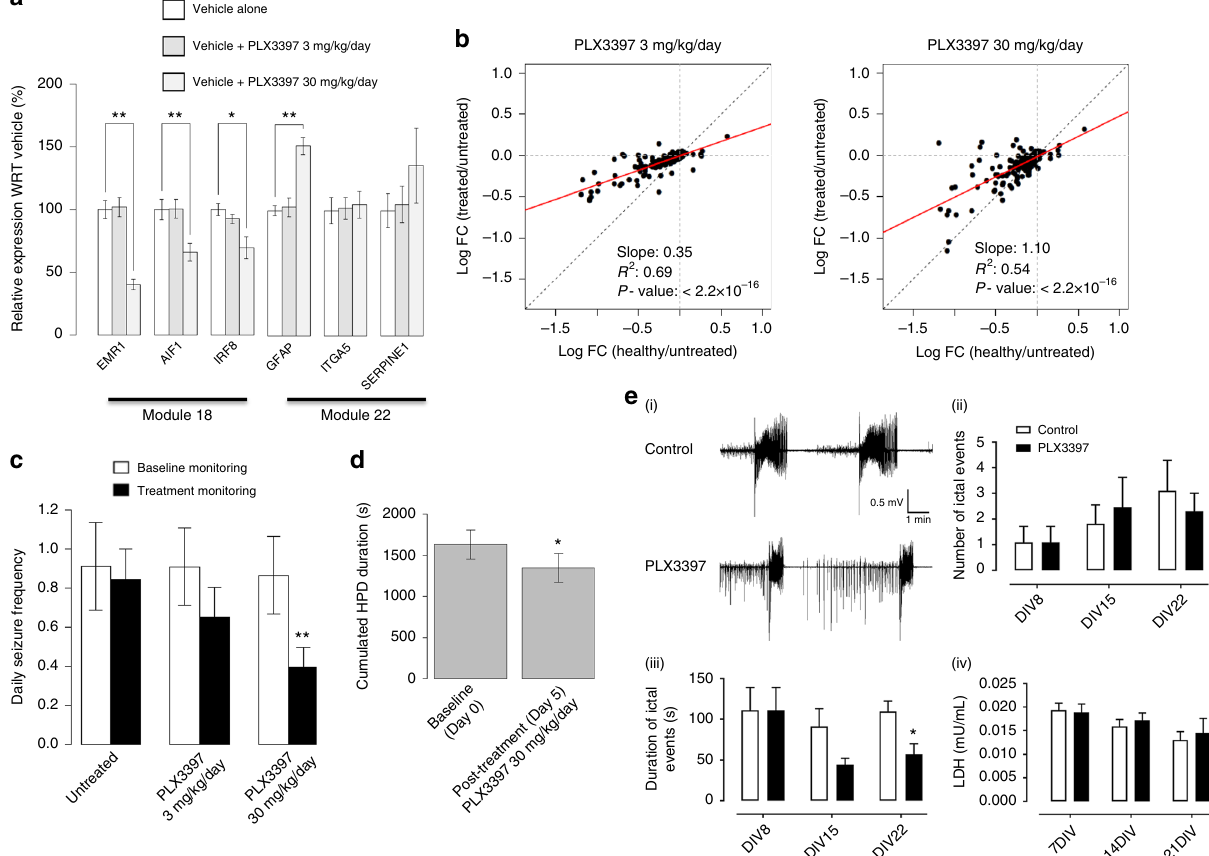
Fig. 4 Effect of PLX3397 on module 18 expression and seizures. a PLX3397 regulates module 18 genes. Epileptic mice were treated daily for 7 days with vehicle or PLX3397 at 3 or 30 mg/kg per day ( n = 8 mice in each group). At the end of the treatment, hippocampal RNA was extracted and the expression of marker genes in modules 18 and 22 was assayed by rt-qPCR. Module 18 marker genes were signi fi cantly down-regulated by PLX3397 at 30 mg/kg per day (* P < 0.05, ** P < 0.01 — one-tailed Welch ’ s t test). b Restoration of module 18 expression in epilepsy toward health by PLX3397. Epileptic mice were treated with PLX3397 at 3 or 30 mg/kg per day or vehicle alone ( n = 8 mice in each group). Hippocampal mRNA was extracted on day 14 of treatment and module 18 expression assayed by microarray. Red line indicates the linear negative correlation between the two conditions compared to a theoretical complete restoration of expression toward the healthy state (dotted black line). Treatment with PLX3397 resulted in a signi fi cant and dose-dependent ( P = 3.6 × 10 − 14 ) restoration of expression of module 18 toward health (i.e., toward the dotted black diagonal). c Ef fi cacy of PLX3397 on seizures —